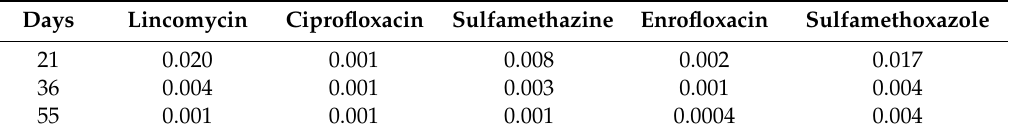
Table 2. Uptake factor (UF) of the antibiotics after 21, 36, and 55 days of growth. (Uptake factor values were calculated from equation: UF = CP / CS, where Cp is the concentration in plant material and Cs is the concentration added to